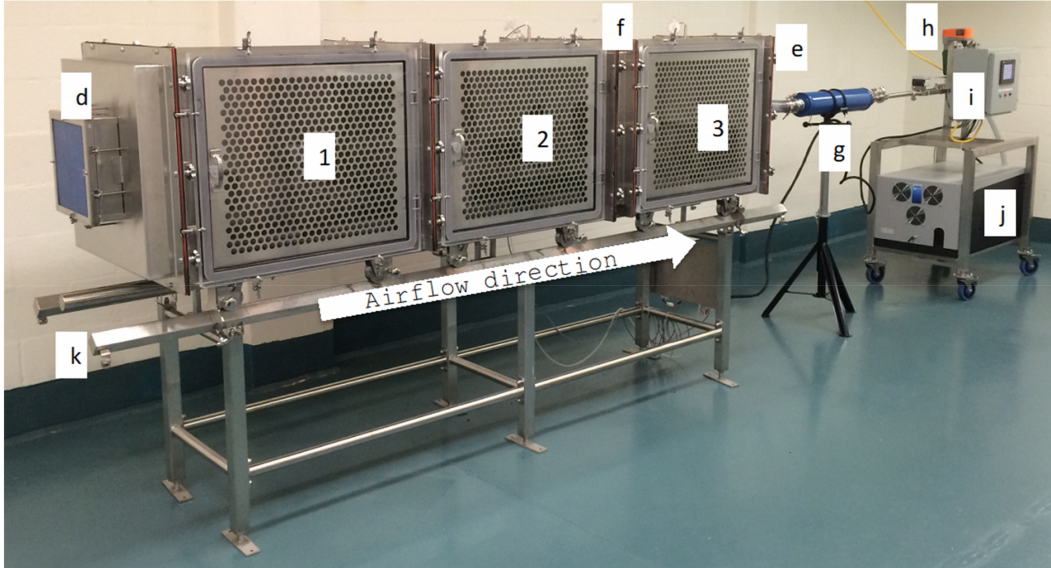
Figure 1. System overview. ( 1 ) Cage number one, ( 2 ) cage number two, ( 3 ) cage number three, ( d ) high-efficiency particulate air (HEPA) filter inlet air, ( e ) HEPA filter exhaust air (not visible in the picture), ( f ) particle separator, ( g ) muffler, ( h ) airflow adjustment valve, ( i ) control panel, ( j ) pump installed in an insulated box, ( k ) support table with rails.